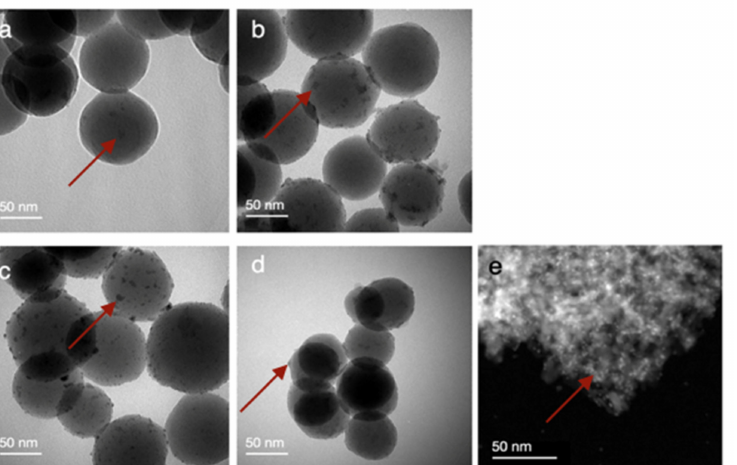
Figure 1. Bright-field TEM images of Ru nanoparticle catalysts on SiO 2 and γ -Al 2 O 3 prepared by deposition-precipitation with following chemical reduction using RuCl 3 , and with a Ru loading on silica of ( a ) 0.98% w / w , ( b ) 2.05% w / w , ( c ) 3.34% w / w and ( d ) 3.88% w / w , ( e ) and on alumina of 3.89% w / w (high-angle annular dark-field scanning transmission electron microscopy). The red arrows illustratively point out a supported Ru